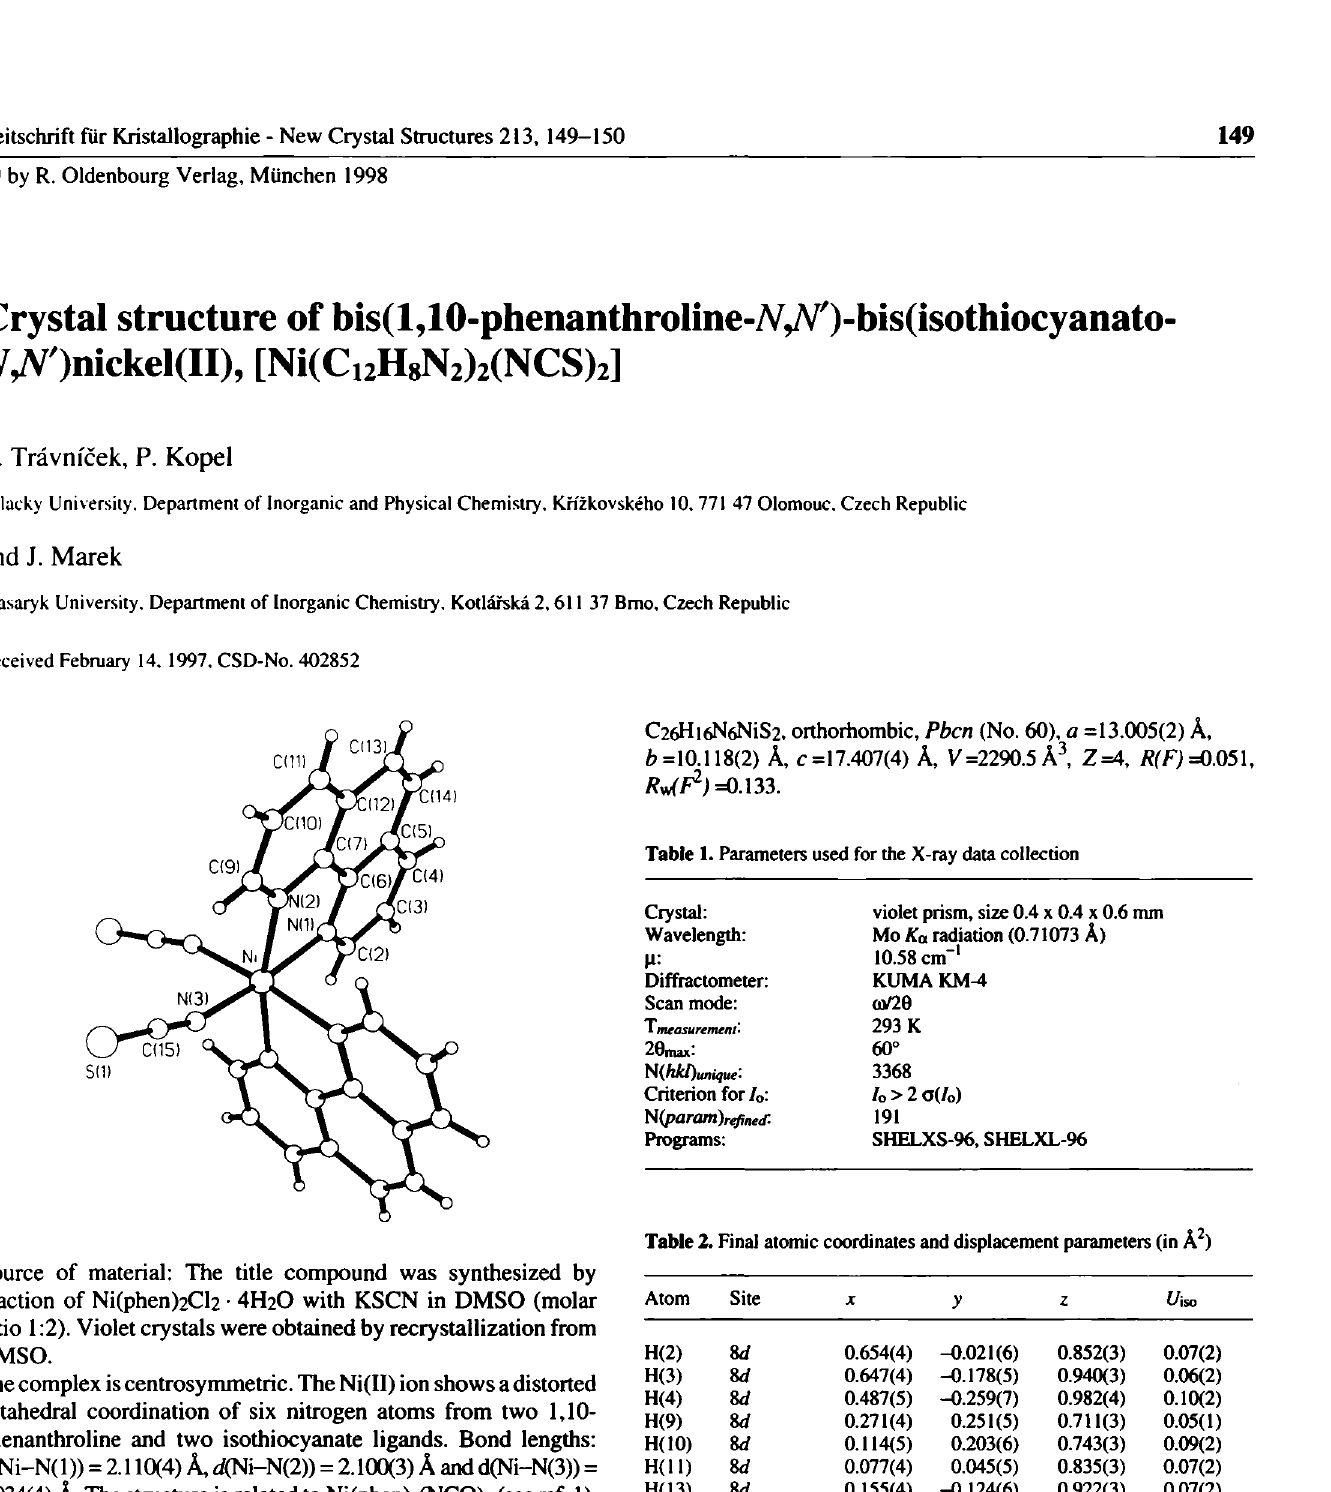
Table 2. Final atomic coordinates and displacement parameters (in À^)